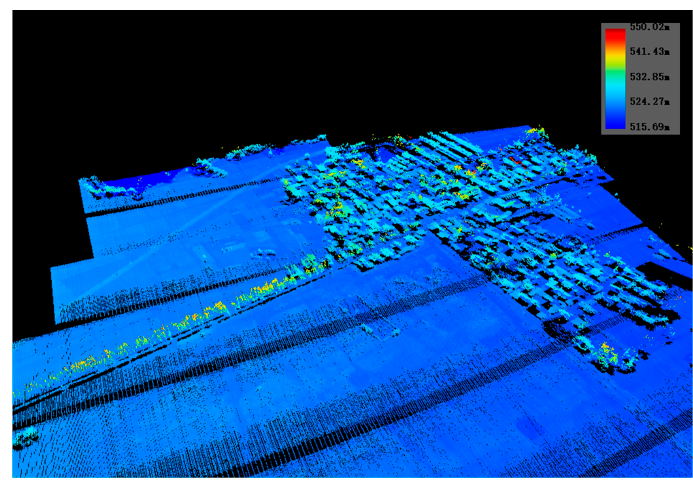
Figure 3. Point cloud of data collection area. Table 1. Data collection details.